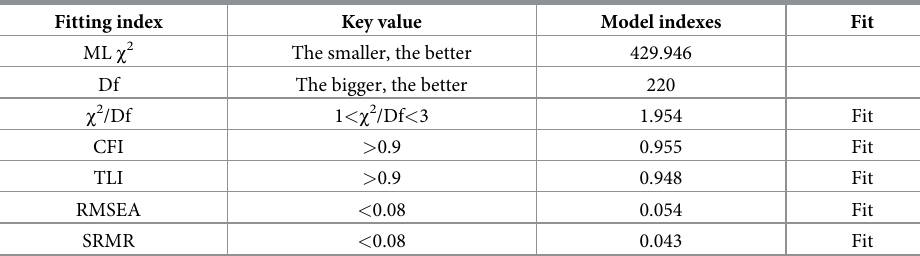
Table 4. Fitting index of overall